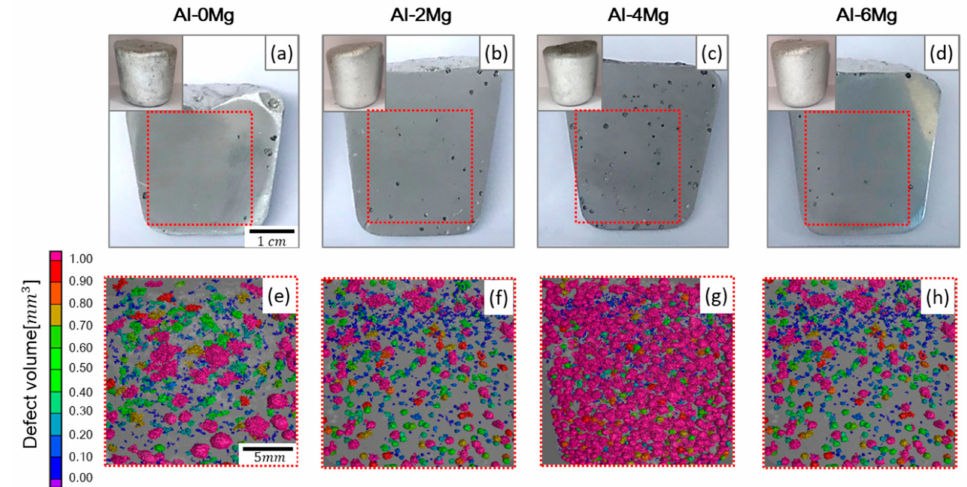
Figure 4. ( a – d ) Photographs of sagittal sections of samples of Al-Mg alloys produced under reduced pressure (insets: whole samples) and ( e – h ) X-ray Computed Tomography results inside red